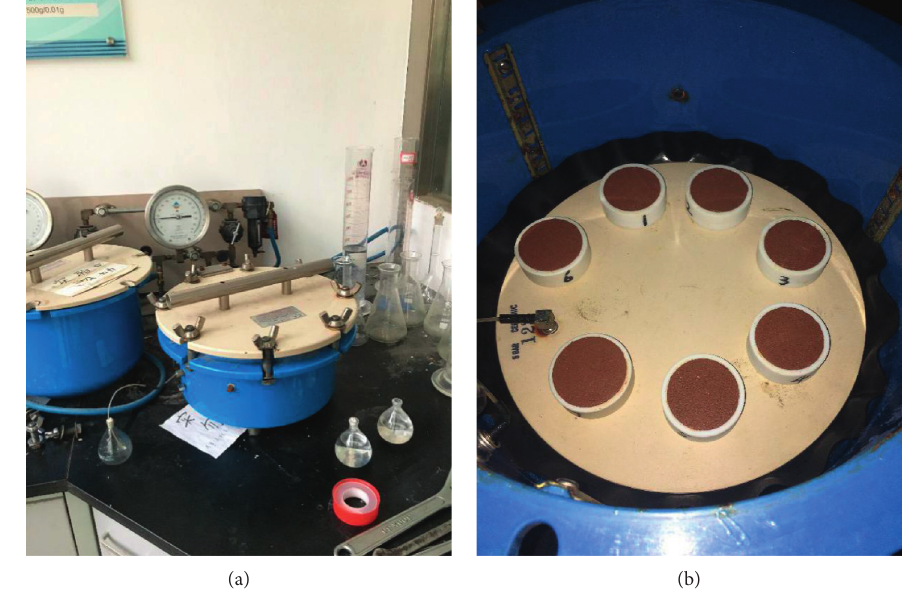
Figure 1: Test steps for pressure plate instrument.